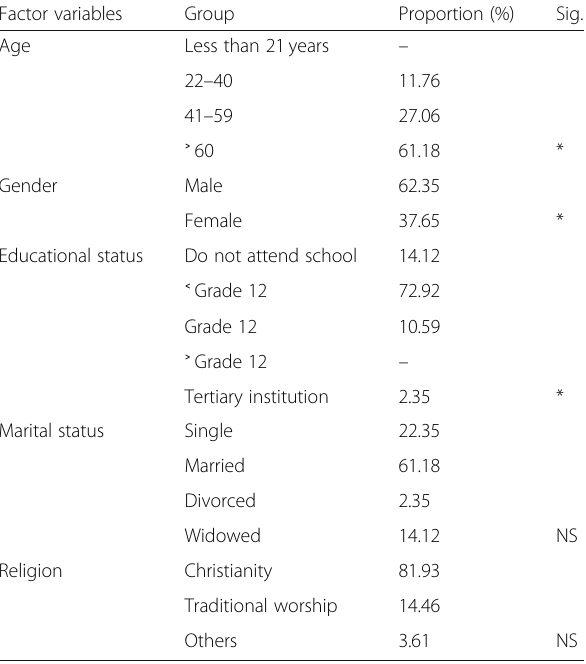
Table 3 Chi-square test result of factors that influence farmers ’